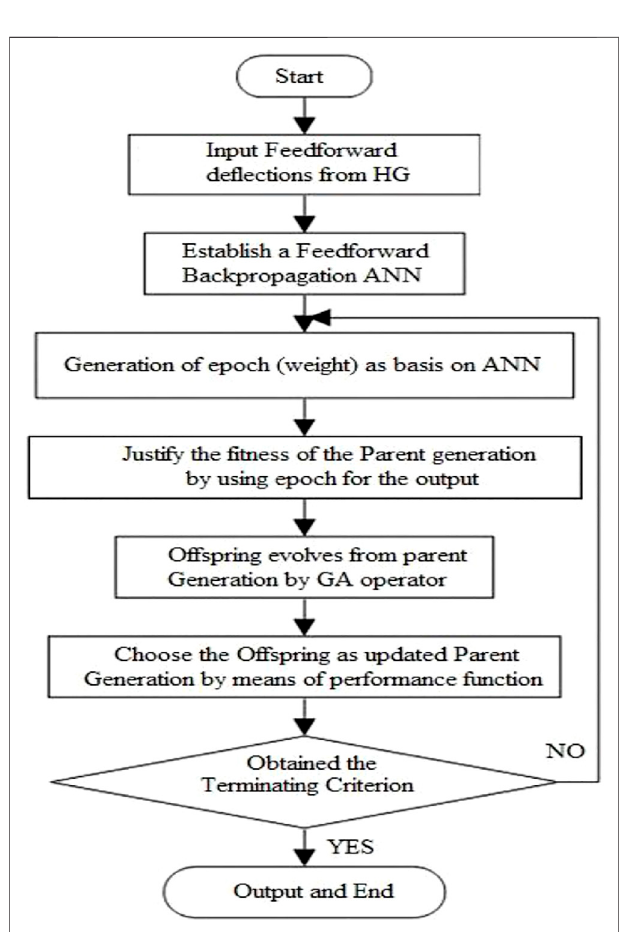
FIGURE 3 | Flowchart of the ANN and the genetic algorithm.